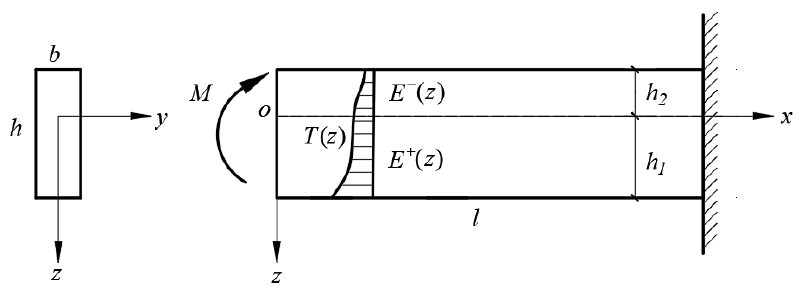
Figure 3. Bimodular FGM cantilever beam under pure bending in thermal environment.